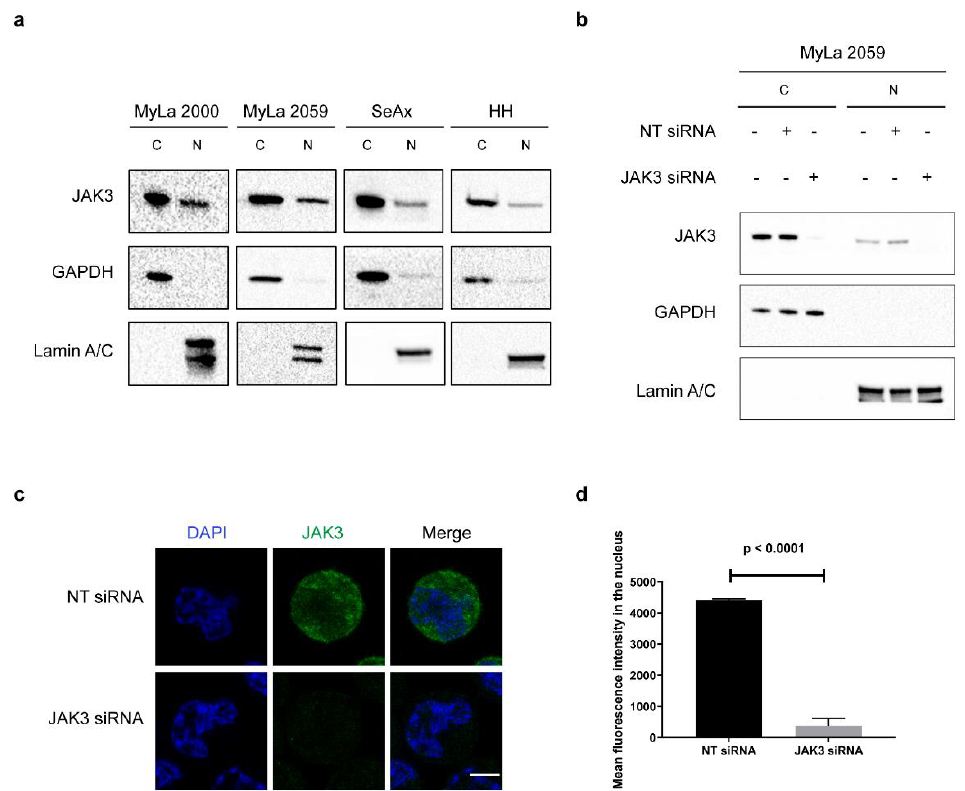
Figure 1. JAK3 is expressed in the nucleus in CTCL cell lines. ( a ) Immunoblot shows JAK3 expression in the cytoplasmic and nuclear extracts of malignant cell lines MyLa 2000, MyLa 2059, SeAx, and HH. ( b ) Immunoblot shows low or no expression of JAK3 in the cytoplasmic (C) and nuclear extracts (N) of MyLa 2059 after 48 h of siRNA mediated knockdown of JAK3. ( c ) Immunofluorescence (IF) of MyLa 2059 confirming JAK3 expression in the nucleus. Scale bar = 5 µ m. NT siRNA is the non-targeted control siRNA and JAK3 siRNA is the siRNA targeted against JAK3 . ( d ) Mean fluorescence intensity of JAK3 calculated in the nucleus of MyLa 2059 after IF. Error bar represents standard error of mean. To address whether nuclear JAK3 expression was a common feature of malignant T cells, we extracted cytoplasmic and nuclear lysates and performed WB using PBMC from patients with SS. Immunoblots showed that JAK3 was expressed in the